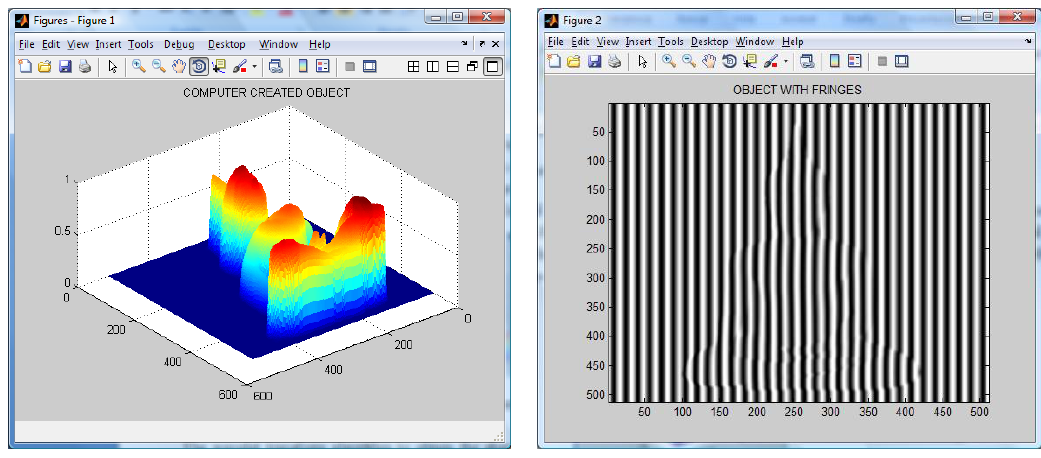
Figure 4. Computer created Buddha and fringes projected on it.